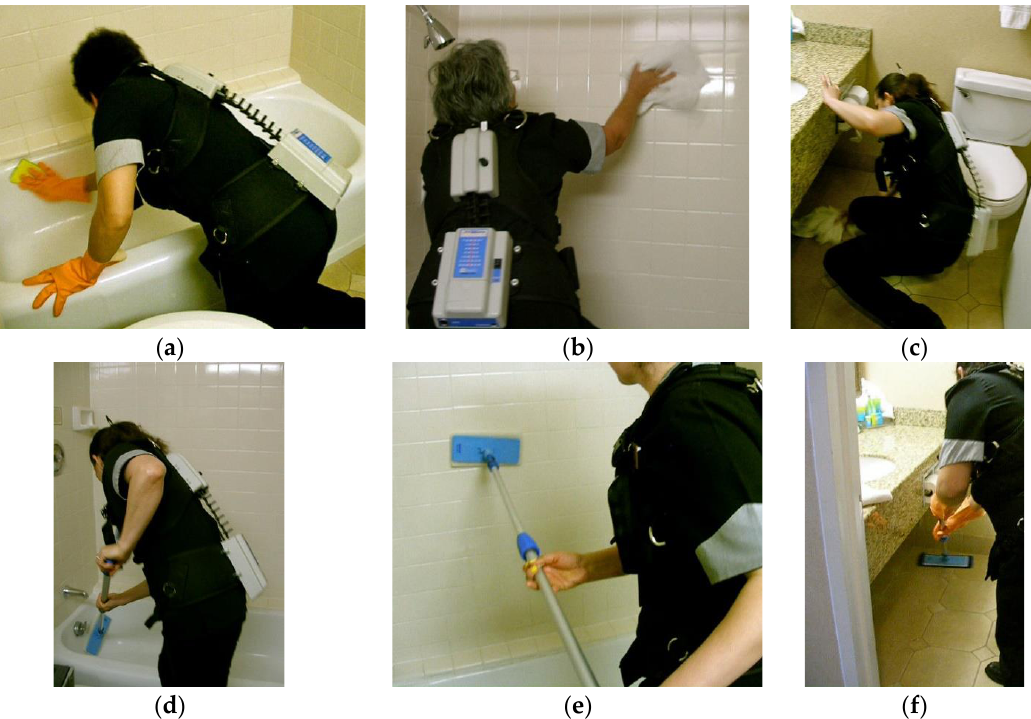
Figure 2. Bathroom-cleaning tasks studied. Wiping down the tub, shower wall tile, and floor using standard methods are shown in ( a – c ), while those tasks done using a tool with an adjustable, long-handle are shown in ( d – f ).